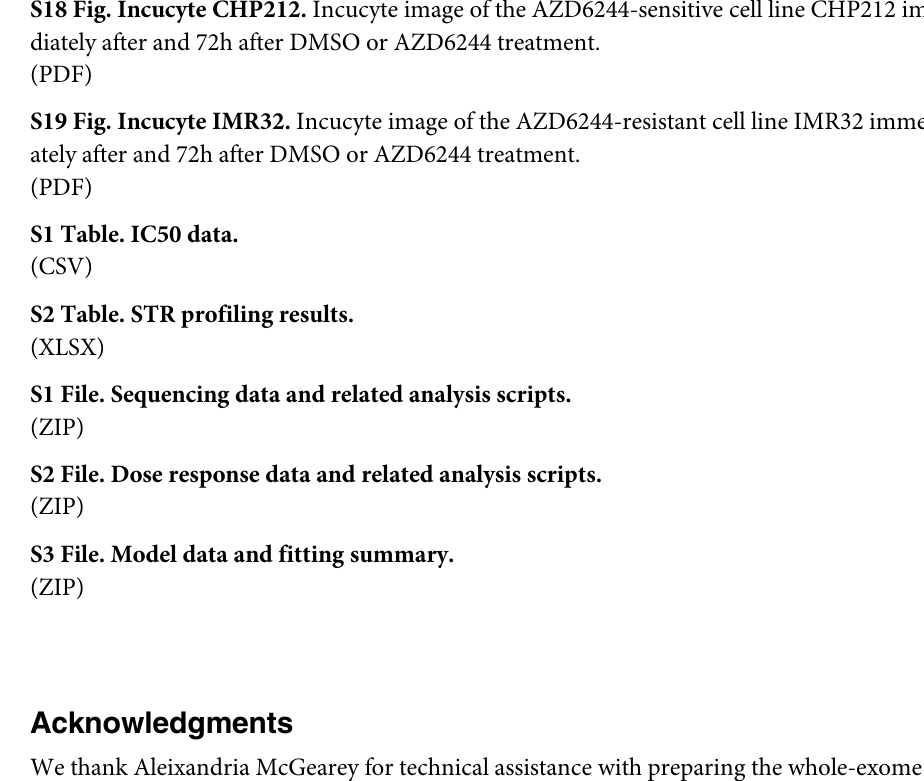
S18 Fig. Incucyte CHP212. Incucyte image of the AZD6244-sensitive cell line CHP212 imme- diately after and 72h after DMSO or AZD6244 treatment. (PDF) S19 Fig. Incucyte IMR32. Incucyte image of the AZD6244-resistant cell line IMR32 immedi- ately after and 72h after DMSO or AZD6244 treatment. (PDF) S1 Table. IC50 data. (CSV) S2 Table. STR profiling